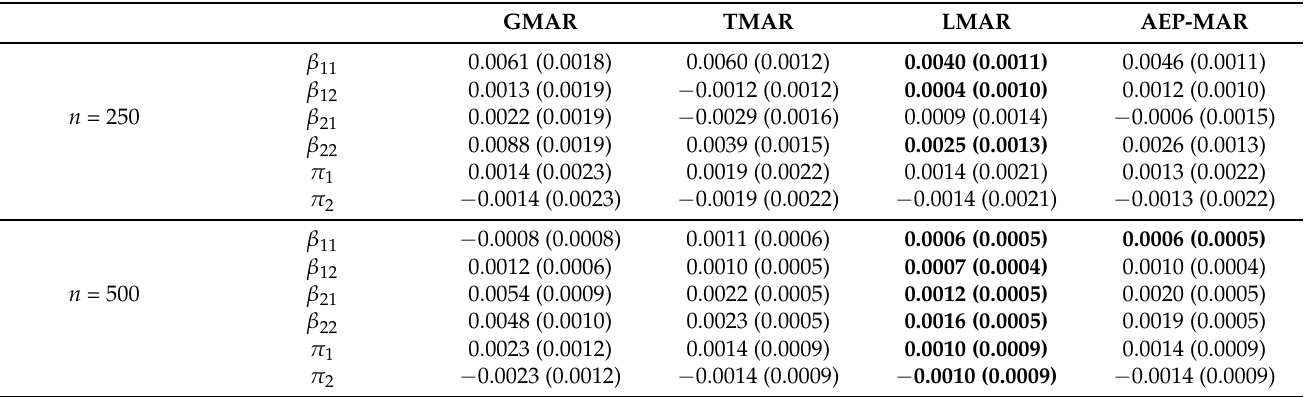
Table 3. Simulation results for Scenario 2 .